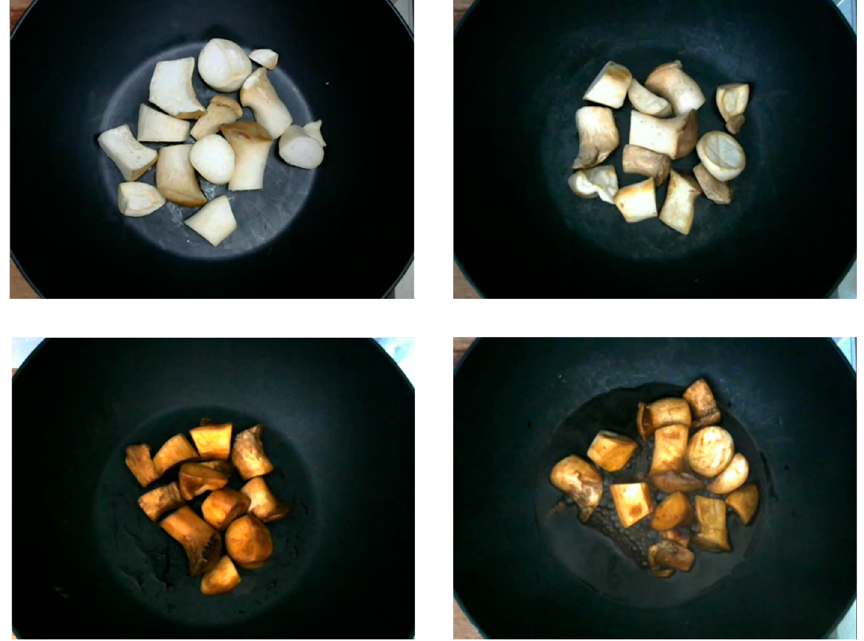
Figure 5. Pleurotus eryngii cooking process. Upper: Beginning, Bottom: Finish. Left: More sauce. Right: Less